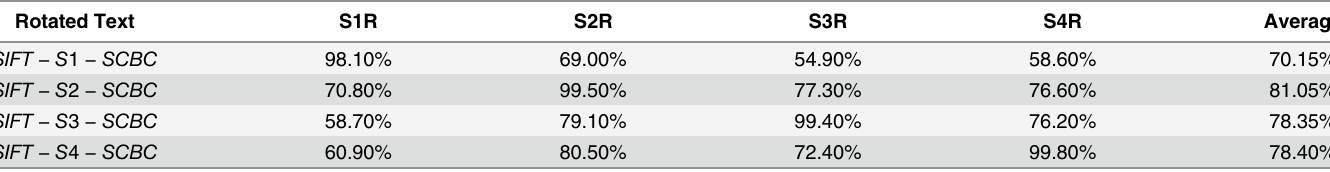
Sizes S1, S2, S3 and S4 with non- rotated ligatures are shown along y-axis, as a test data. The correct classi fi cation rate (%) is shown at intersection of two axis for each distinct SCBC